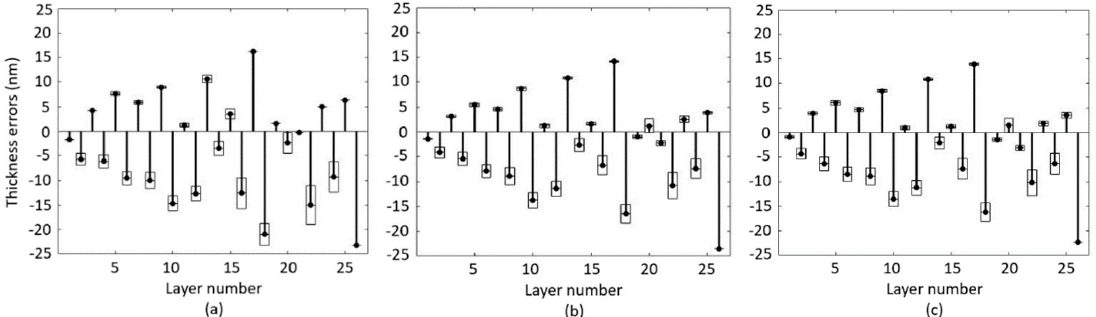
Figure 4. Results of the characterization using online transmittance data from the real deposition run: average values of thickness errors and fluctuations of thickness errors found using the modified S-algorithm ( a ); modified T-algorithm ( b ); and T-algorithm ( c ).